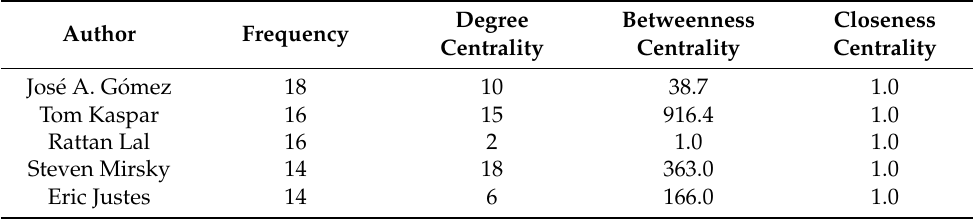
Figure 7. The results of co ‐ authorship network analysis. Table 7. The centrality of the top 5 productive authors in the co ‐ authorship network. Table 7. The centrality of the top 5 productive authors in the co-authorship